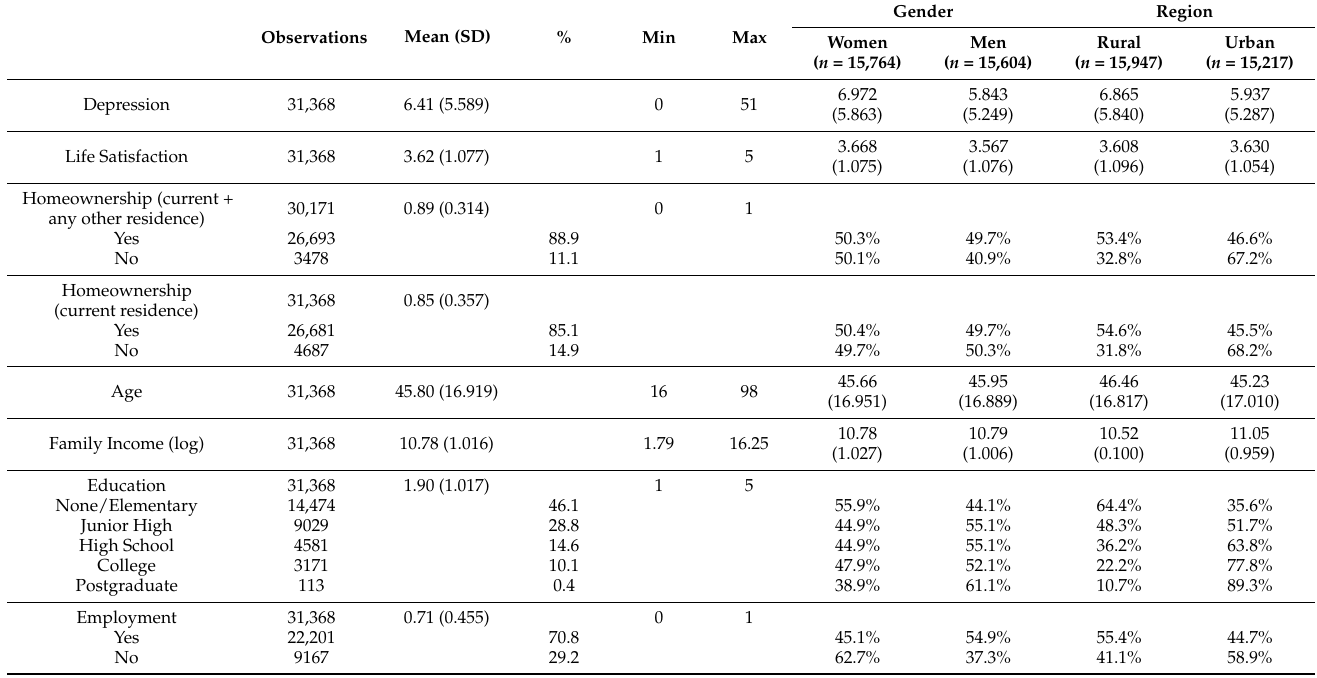
Table 1. Summary Statistics of Key Variables ( n =